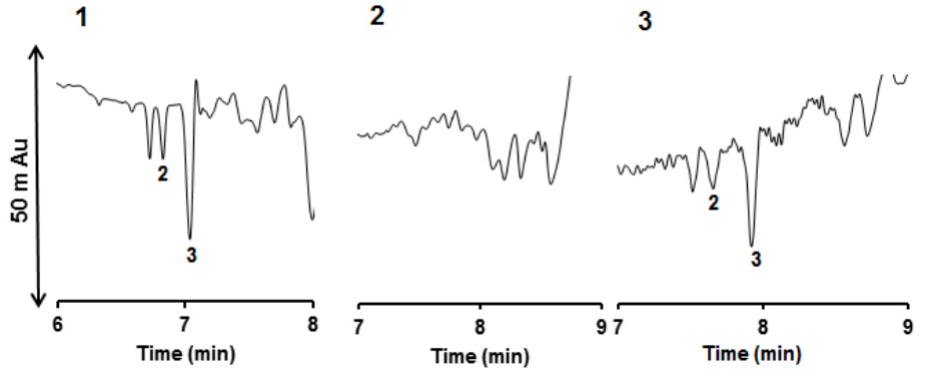
Figure 5. Electropherograms obtained from analysis of the three extraction methods, respectively, Hara & Radin, Micro Folch and Bligh & Dyer methods. Peaks: 1-C16:0, 2-C18:2 and 3-C18:3. Operational conditions: injection 4 s 12.5 mbar, voltage +19 kV, indirect detection at 224 nm and 25°C temperature inside the cartridge, TSH capillary with 48.5 cm long (40 cm effective length) 75 μm I.D and 375 mm